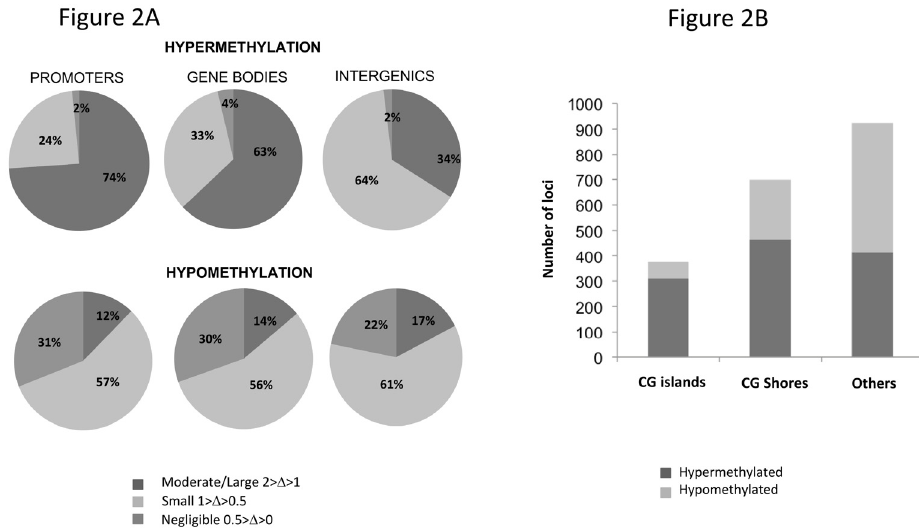
Fig 2. Magnitude and Direction of differential methylation and its distribution across genomic compartments. (A) All NSCLC histologies DM was classified as negligible, small or moderate based on the absolute value. (1 < abs delta < 2 is Moderate/Large; 1 < abs delta < 0.5 is Small; 0.5 < abs delta < 0 is Negligible). DM loci with FDR p < 0.05 based on paired T-test were considered for this analysis. Majority of hypermethylation in tumors is observed to be of moderate/large magnitude in promoters and gene bodies, while in the intergenic regions, small changes are most frequent. The majority of hypomethylation is observed to be of small magnitude in all the three compartments. A significant fraction of hypomethylation changes are of negligible magnitude yet statistically significant. (B) Direction of DM and the distribution within promoters categorized based on location within CG-islands and CG-shores. Within the category of DM promoter loci, hypermethylation is more frequent in tumors as compared to hypomethylation for those loci within CG-islands and CG-shores. Overall DM differences do vary by PR genomic location (CGI, CGS, other); all NSCLC histologies were ChiSquare p = 2.2E-16; adenocarcinoma-only histology ChiSquare p =